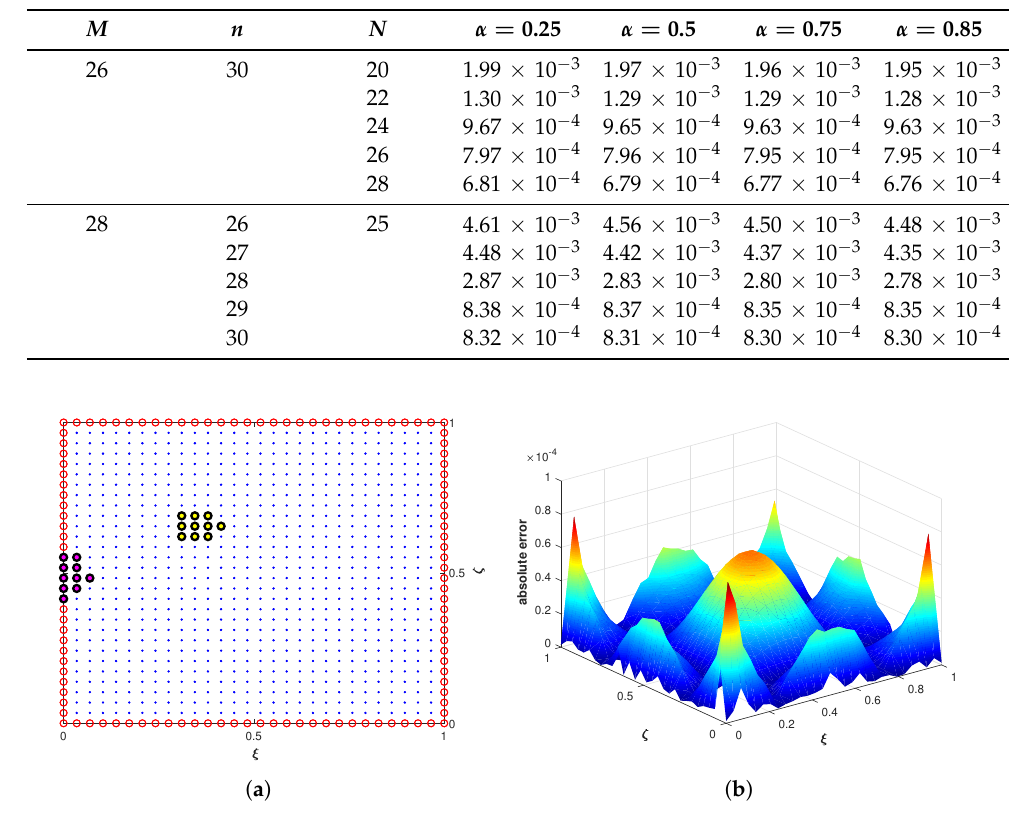
Figure 8. ( a ) Square domain with N = 900 in the global domain and n = 20 in the local domain, magenta corresponds to boundary and yellow corresponds to interior nodes. ( b ) Absolute error of Problem 3 with α = 0.85, N = 900, n = 30, and M = 28.